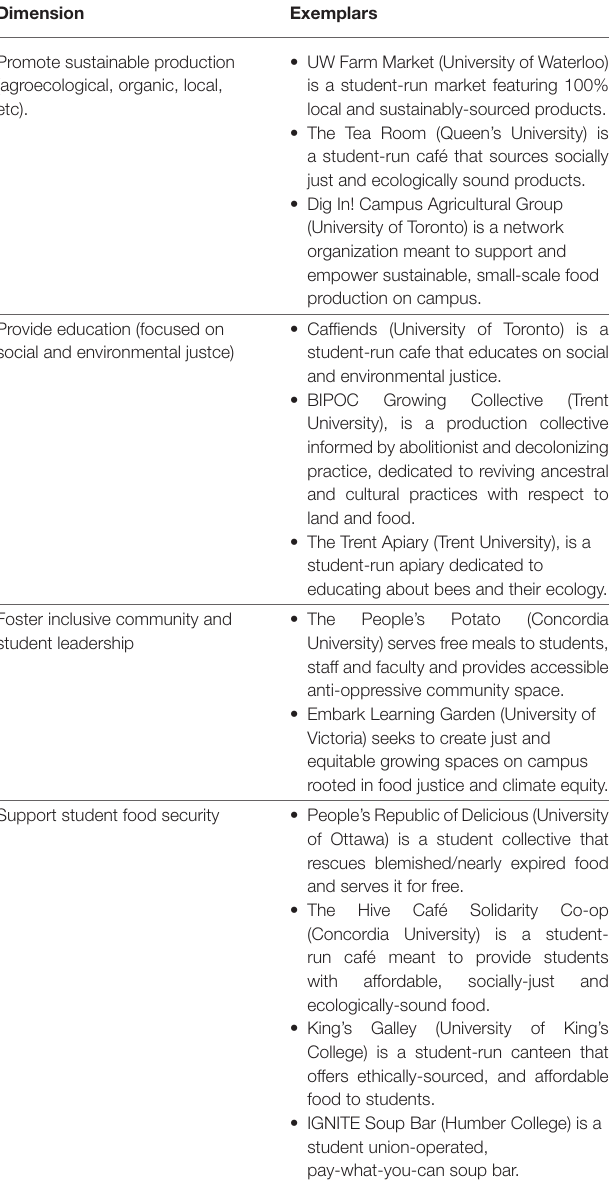
TABLE 1 | Categorization schema for CFSA. Dimension Exemplars Promote sustainable production (agroecological, organic, local,